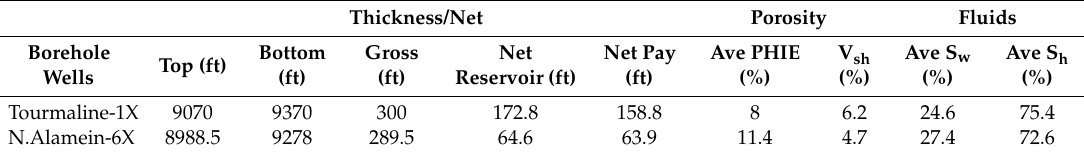
Table 1. Petrophysical parameters for Alamein Formation for Tourmaline-1X and N.Alamein-6X wells.